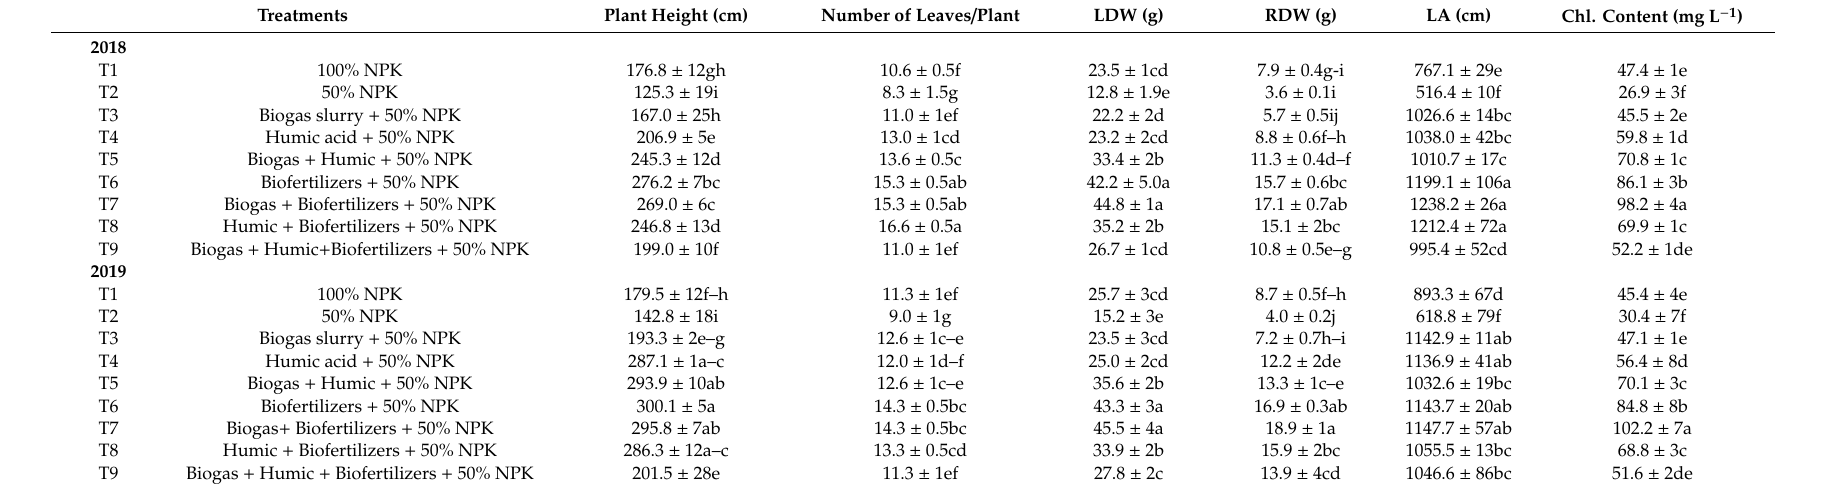
Table 3. Morpho-physiological traits of maize treated with organic and biofertilizers alone or in combination.